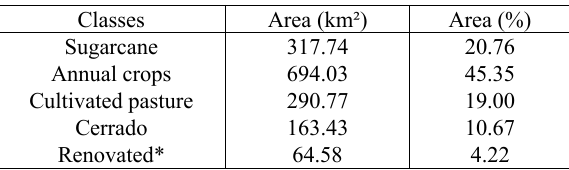
Table 3. Total area mapped with Harmonized Landsat 8 Sentinel-2 (HLS30) images and Random Forest classifier, per class. *Renovated sugarcane